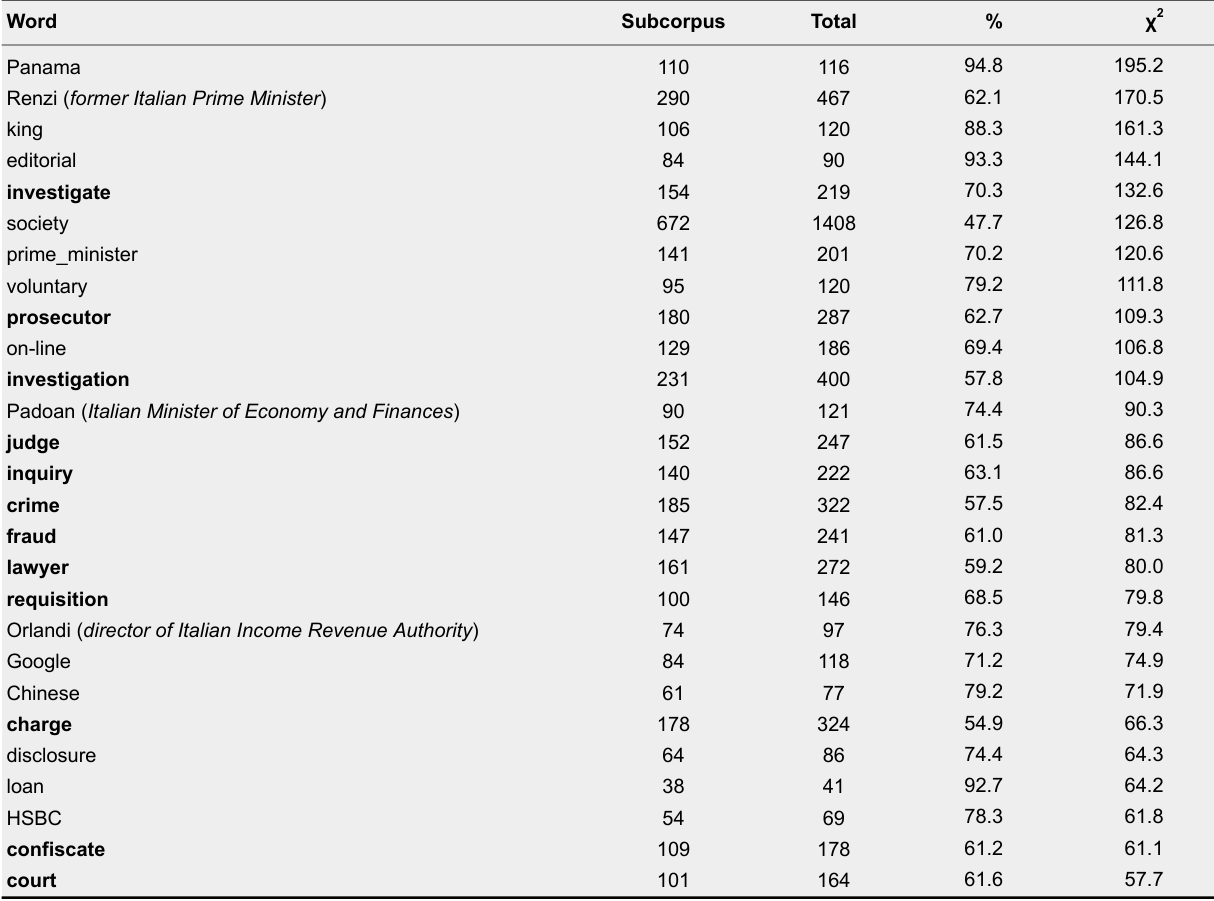
Specificity Analysis: Overused Words in Italy Between 2015 and